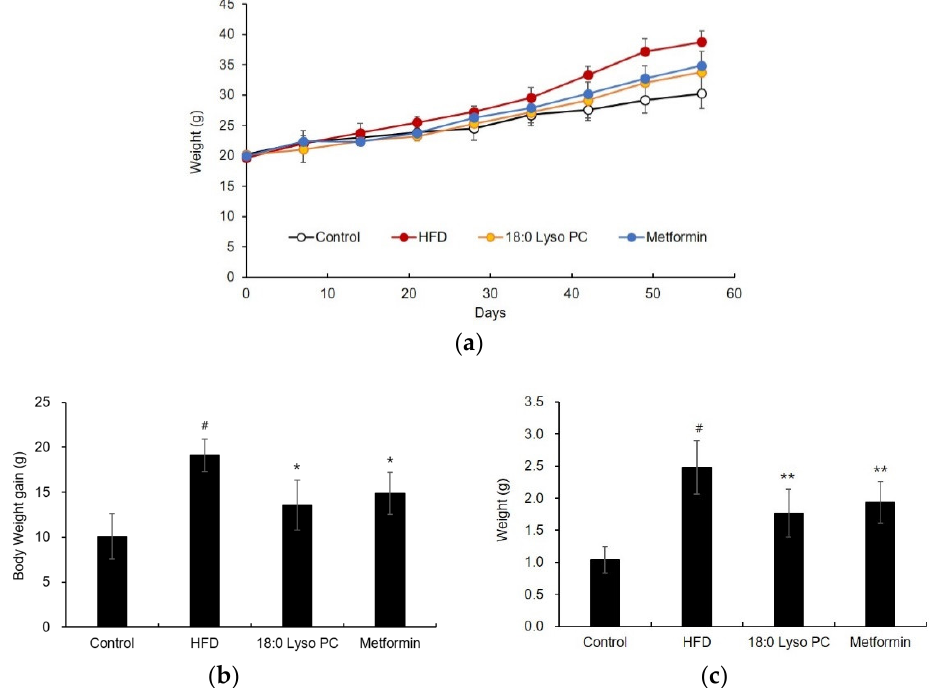
Figure 2. Effect of 18:0 Lyso PC on ( a ) changes in body weight during the entire experimental period